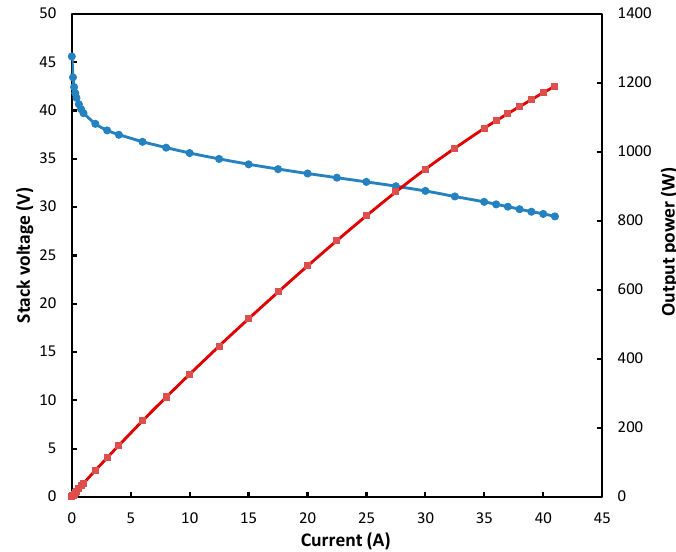
Figure 3. Performance of PEMFC stack.